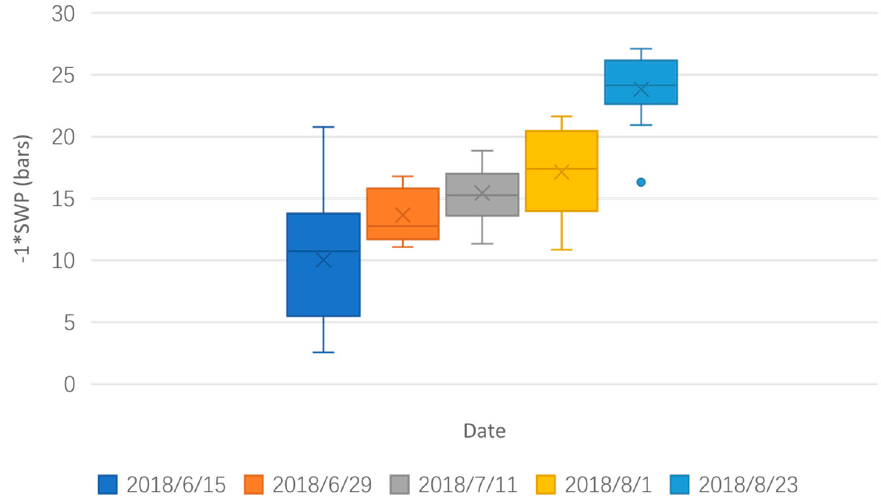
Figure 3. Measured stem water potential (-1* swp (bars)) with bars indicating average and standard deviation during the cotton growing season.